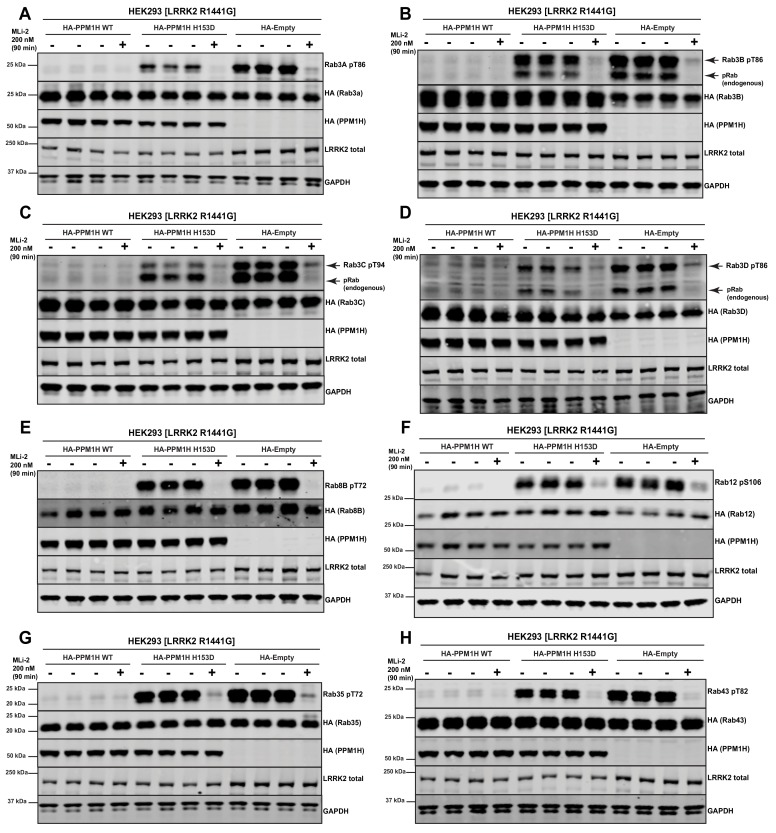
PPM1H dephosphorylates multiple LRRK2 phosphorylated Rab proteins.(A–H) HEK293 cells were transiently transfected with constructs expressing the indicated components. 24 hr post-transfection, cells were treated ±200 nM MLi-2 for 90 min and then lysed. 10 µg whole cell lysate was subjected to LI-COR immunoblot analysis with the indicated antibodies at 1 µg/mL concentration. Each lane represents cell extract obtained from a different dish of cells.